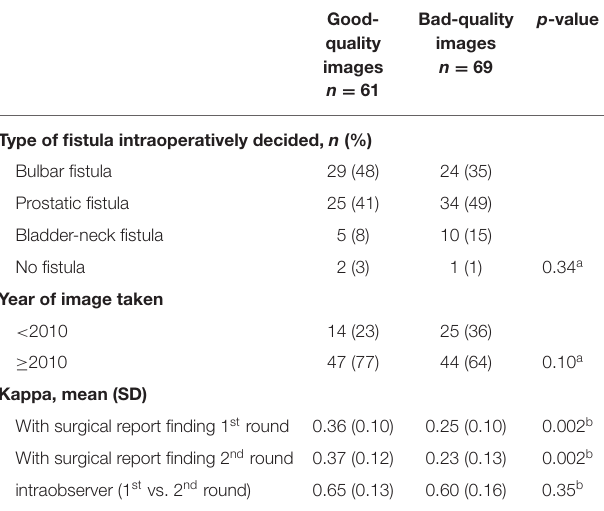
TABLE 2 | Difference between good- and bad-quality images in type of fistula, year of image, agreement on scoring the images, and intra- and interobserver